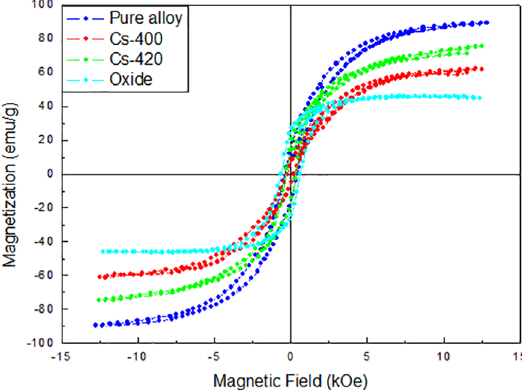
Figure 8. Vibrating sample magnetometer measurement done at room temperature for the sample: pure alloy, CS-400, CS-420 and pure oxide. Table 4. Saturation magnetization (Ms), ratio between the remaining magnetization Mr and Ms (Mr/Ms), coercive field (Hc) for oxide, pure alloy, CS-400 and CS-420